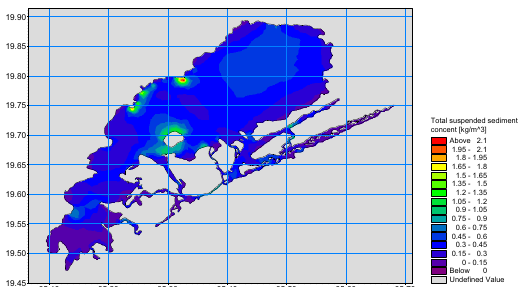
Figure 7d. Simulated spatial profile of Total Suspended